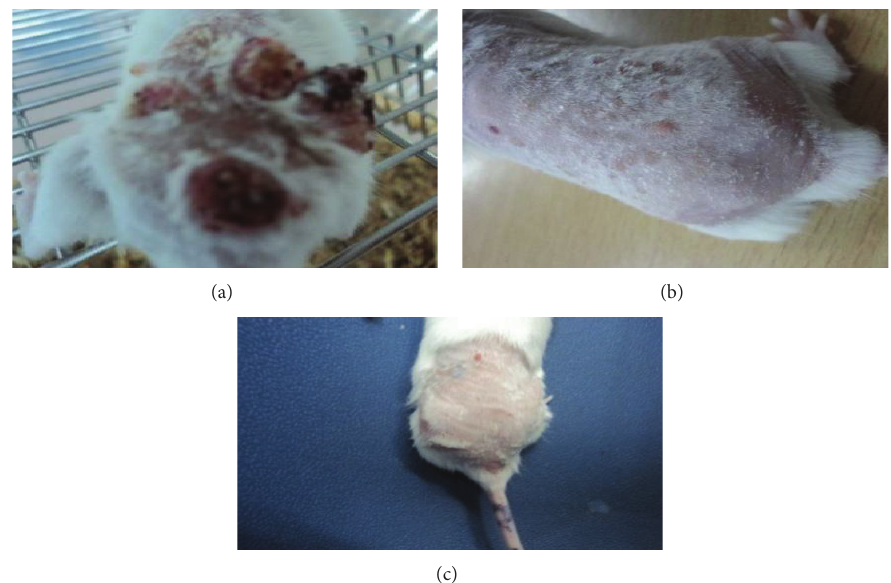
Figure 3: Flavonoid-induced reduction of tumor in Swiss albino mice. (a) Group 2 (water + DMBA + croton oil), (b) Group 4 (palmatine